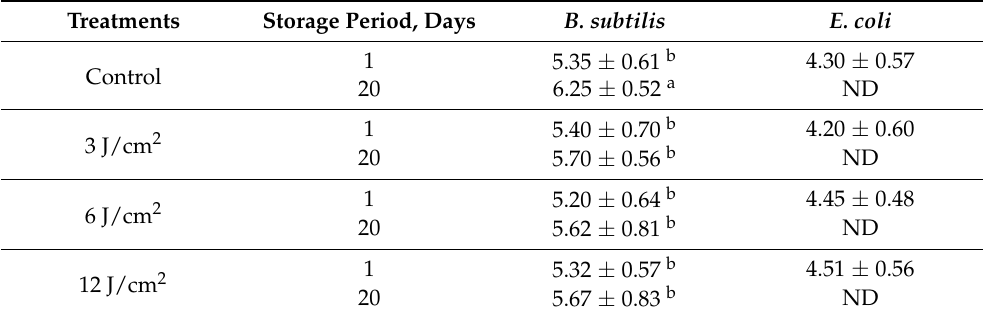
Table 6. Growth of B. subtilis and E. coli (Log CFU/g) in different Labneh treatments during the shelf-life